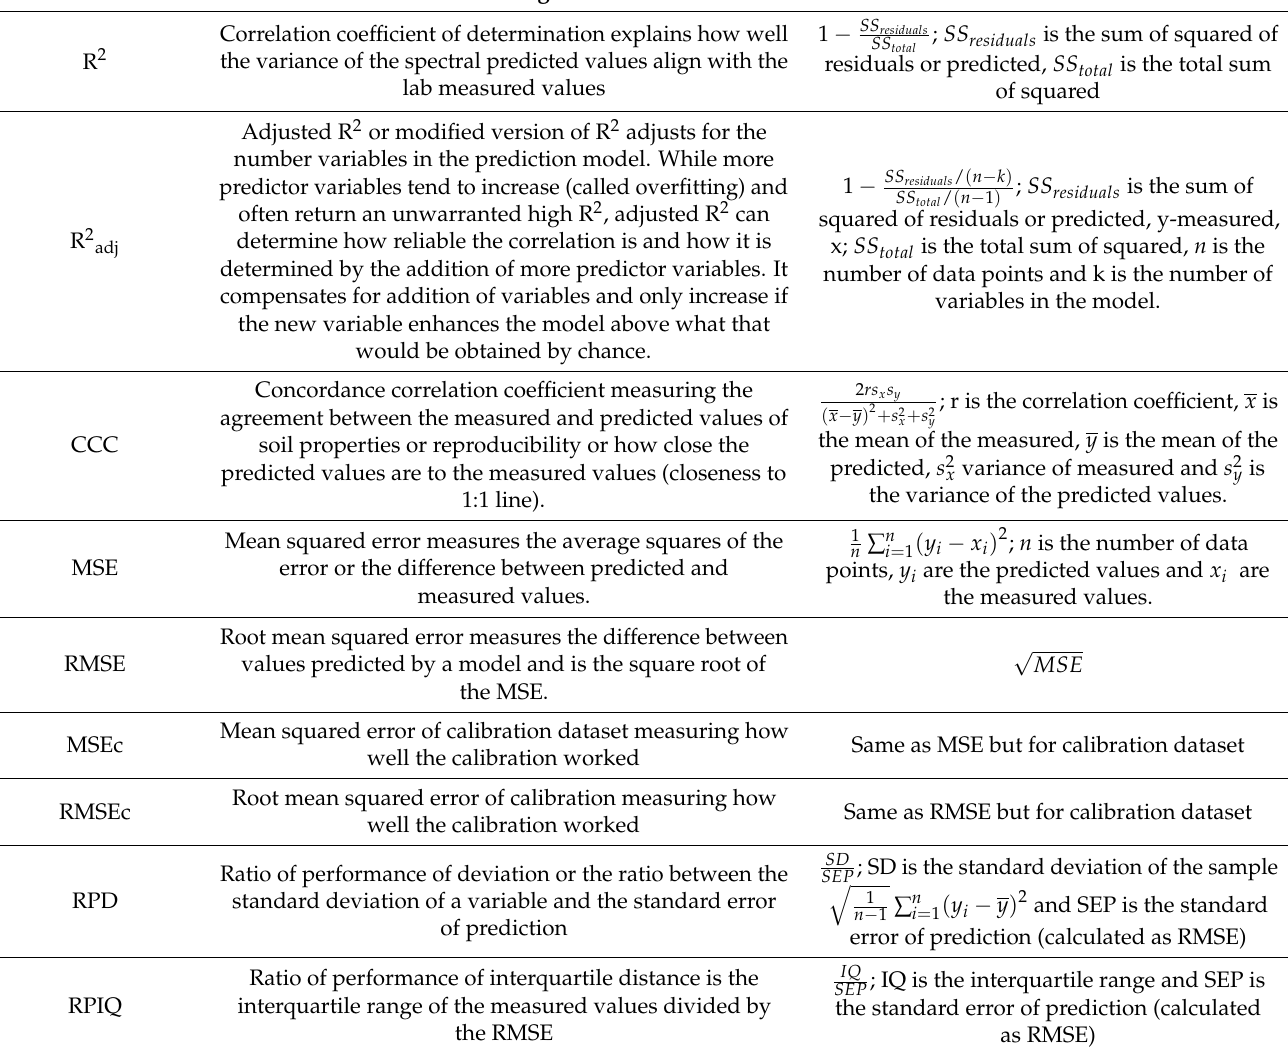
Table 4. Brief description of the model performance indicators used in this study with their formula. Indicator Meaning